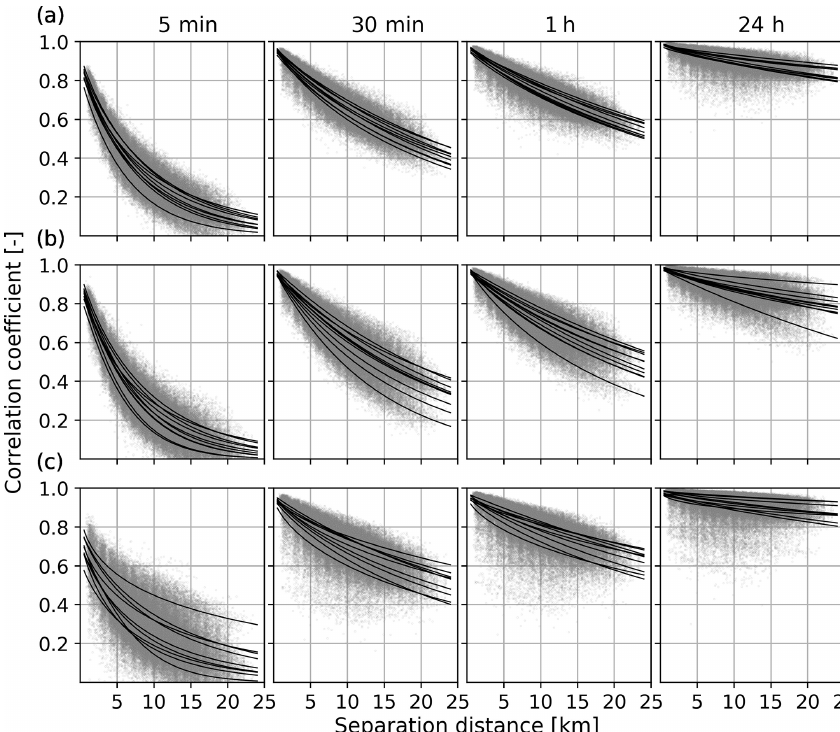
Figure 3. Spatial correlation of rainfall among rain gauges for (a) all months, (b) warm season, and (c) cold season. Four selected accumu- lation times are shown. Each solid line represents a fitted exponential function for each year up to 23km (the longest inter-gauge distance of WEGN). Note that the function is fitted to correlation for separation distances ≤ 15km to sample data uniformly for any spatial